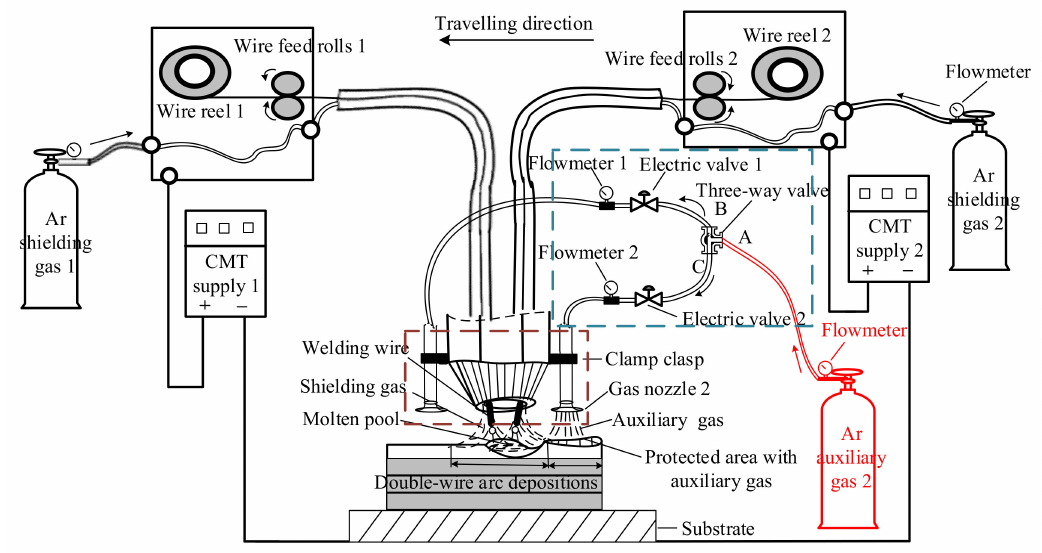
Figure 1. Platform of auxiliary gas process in double-wire SS316L stainless steel arc additive